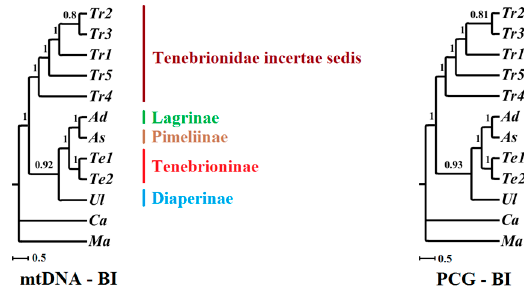
Figure 8. Cont. Figure 8.